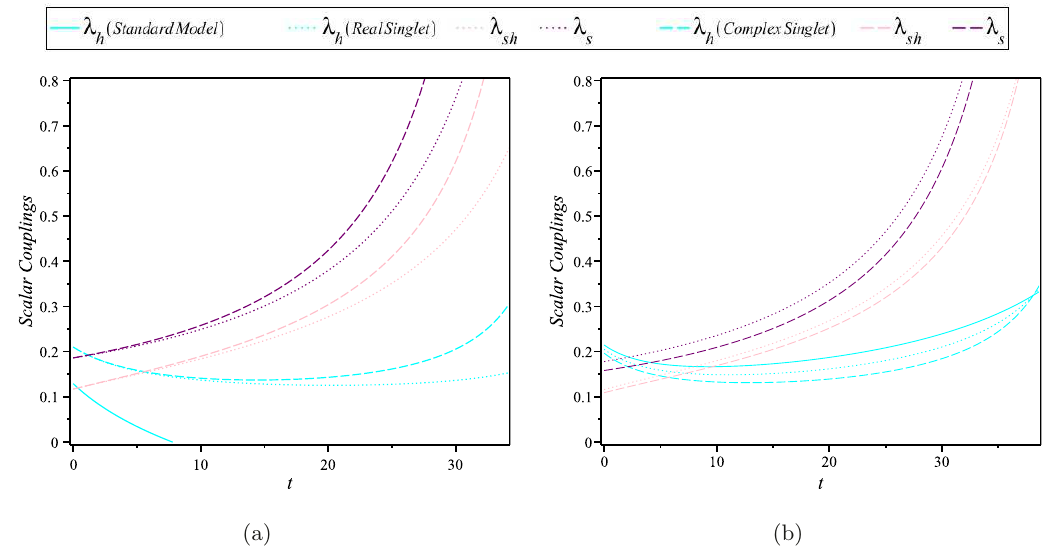
Figure 2 . Running of the couplings incorporating two-loop corrections, toward unification (a) or from unification (b). Solid lines are for the SM, dots are for when the real scalar singlet is present, and dashed lines are for the case that the singlet field is complex. In case of SM, except for the neutrino Yukawa coupling, the initial values are coming from experiments. In all the cases, the initial values for experimentally unknown couplings are discussed in the next section; when we run from unification and look for the best